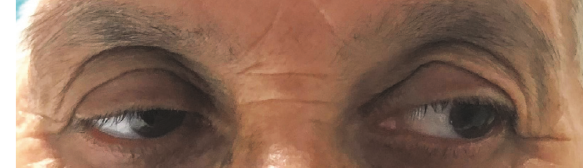
Figure 6: Photograph showing the resolved oculomotor palsy with full adduction of right